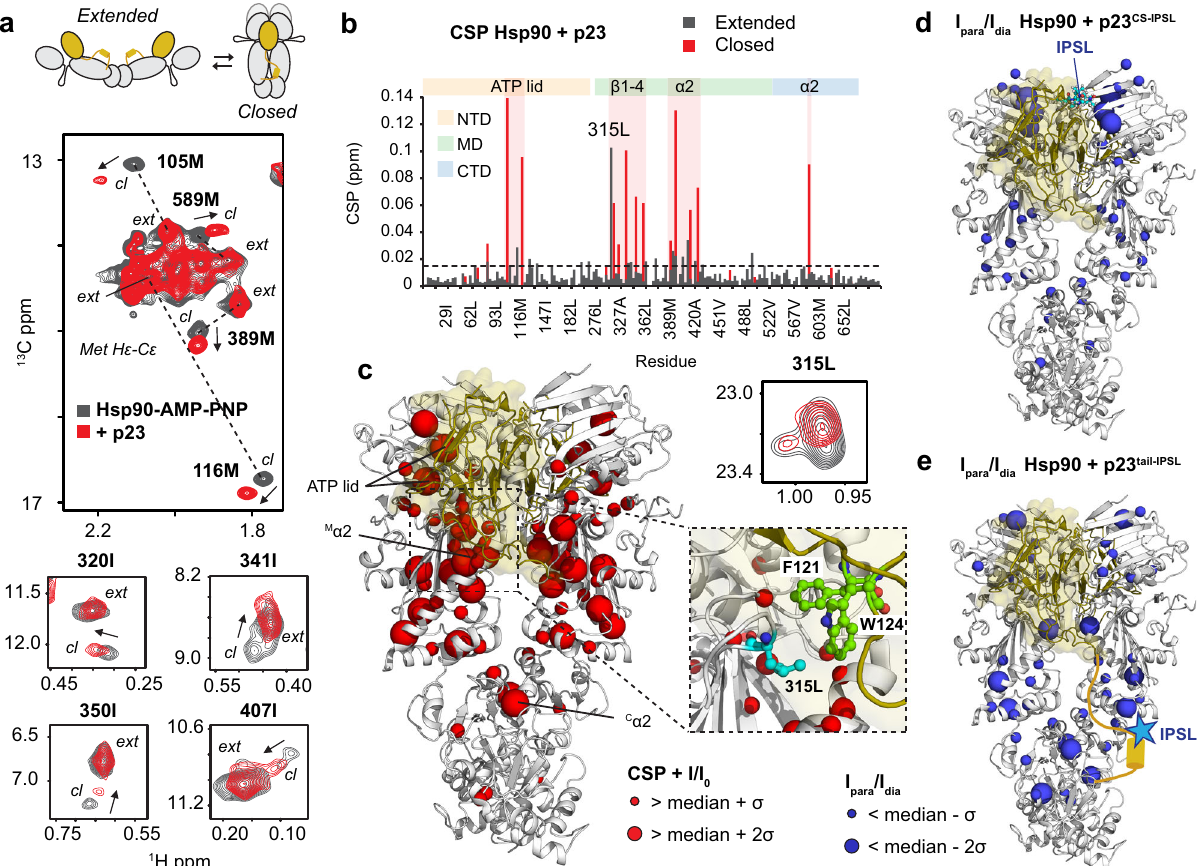
Fig. 4 NMR Analysis of the interaction of p23 with Hsp90. a p23 triggers strong spectral changes for methyl signals in 1 H- 13 C methyl-TROSY correlations. Top: schematic indicating open and closed conformations of the Hsp90 dimer with p23 CS and tail shown as yellow sphere and line. Middle: zoomed view of the methionine methyl region of the Hsp90-AMP – PNP spectrum in the absence (gray) and presence of 2.4 equivalents of p23 (red). Methyl signals corresponding to extended ( ext ) and closed ( cl ) conformations (in the presence of AMP – PNP) are connected by a dashed line. Chemical shift perturbations (CSP) induced by p23 binding that affect residues in the ATP lid, the helix α 2 in the MD and the α 2 helix projecting from the CTD are indicated by arrows. Bottom: CSPs induced by p23 binding for isoleucine methyl signals in the MD. Only the methyl signals corresponding to the closed conformation are affected by p23 binding. b CSP vs. residue number for methyl signals corresponding to extended and closed Hsp90 conformations upon binding of p23 (gray and red, respectively). Elements experiencing larger perturbations are highlighted in red and indicated at the top. c Perturbations and intensity changes are mapped onto the crystal structure of the Hsp90:p23 complex (PDB: 2CG9) as red spheres, p23 is shown in gold. A detailed view of the p23-Hsp90 interface is included on the right, indicating the most affected F121 and W124 residues of p23 (green) and L315 of Hsp90 (cyan). Zoomed view of L315 methyl resonance is shown at the top. d Intermolecular PRE of the complex with p23 spin labeled at residue 35 in the CS domain (Cys35-IPSL, cyan spheres). Residues experiencing line broadening are shown as blue spheres on the crystal structure. e PRE experiments using spin-labeled p23 C35A/ S189C with IPSL conjugated to residue 189 fl anking the helical motif in the p23 tail. Paramagnetic effects on several MD/CTD residues (blue spheres) indicate transient interactions with the tail helix. Experiments were performed at 100 μ M of Hsp90 and p23 spin labeled at 2:1 ratio corresponding to 80% of a 2:1 complex of Hsp90:p23, according to the stoichiometry obtained by ITC. Only one paramagnetic center was used for the calculations by arti fi cially removing one p23 chain. In order to account for the different paramagnetic effects on the two protomers, the intensity ratios for protomers A and B were